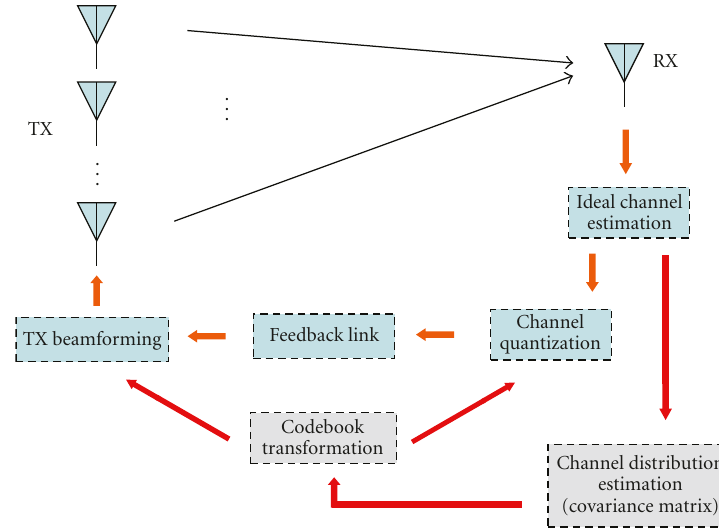
Figure 1: System diagram of a MISO beamforming system with limited CSI